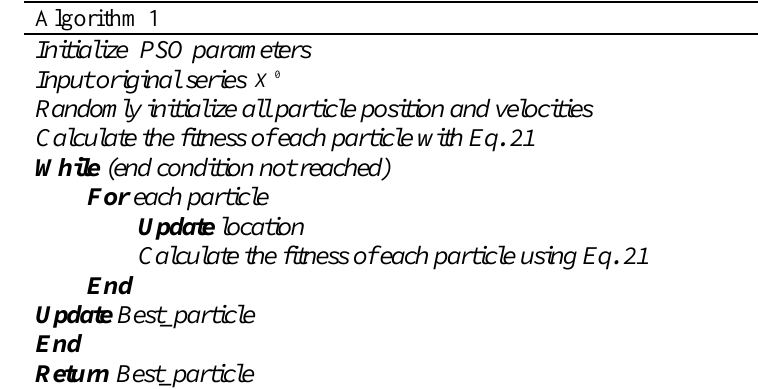
Figure 2: Pseudo-code of the proposed